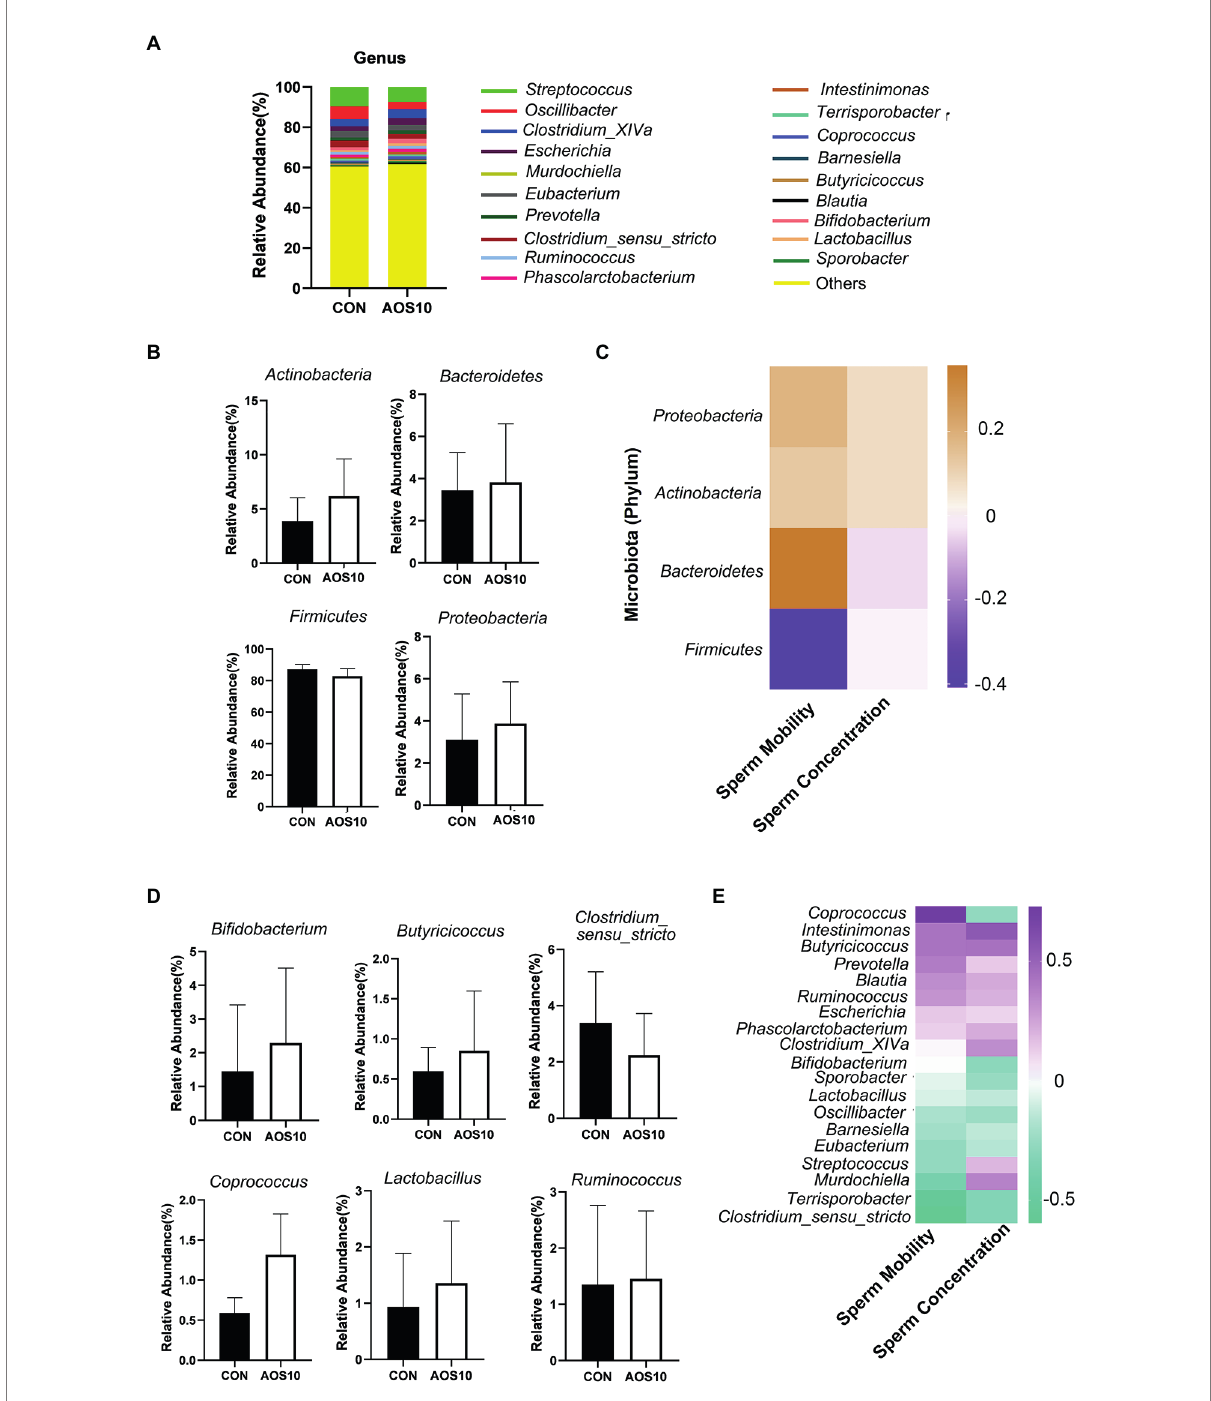
FIGURE 5 The influence of AOS on boar gut microbiota. (A) Differences of bacterial abundance at the genus level. Y-axis = relative abundance, X-axis = treatment group (mg/kg body weight). (B) Differences of bacterial abundance at the class level. (C) Correlation of bacterial abundance at the class level with sperm motility and concentration. (D) Representative differences of bacterial abundance at the genus level. Y-axis = relative abundance, X-axis = treatment group (mg/kg body weight). (E) Correlation of bacterial abundance at the genus level with sperm motility and